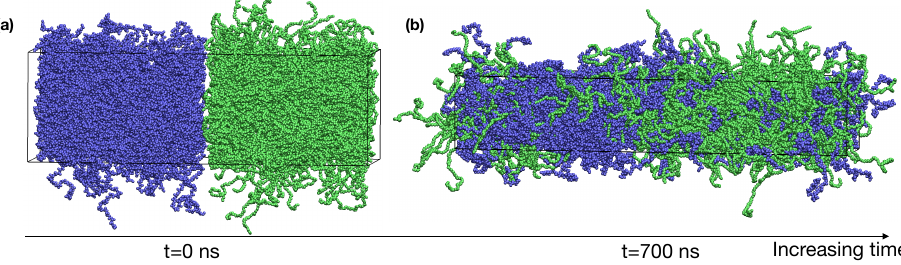
Figure 1. ( a ) A snapshot of the initial configuration of PE/iPP with sharp interfaces; ( b ) an equili- brated PE/iPP blend at 400 K. iPP (blue), PE (green).